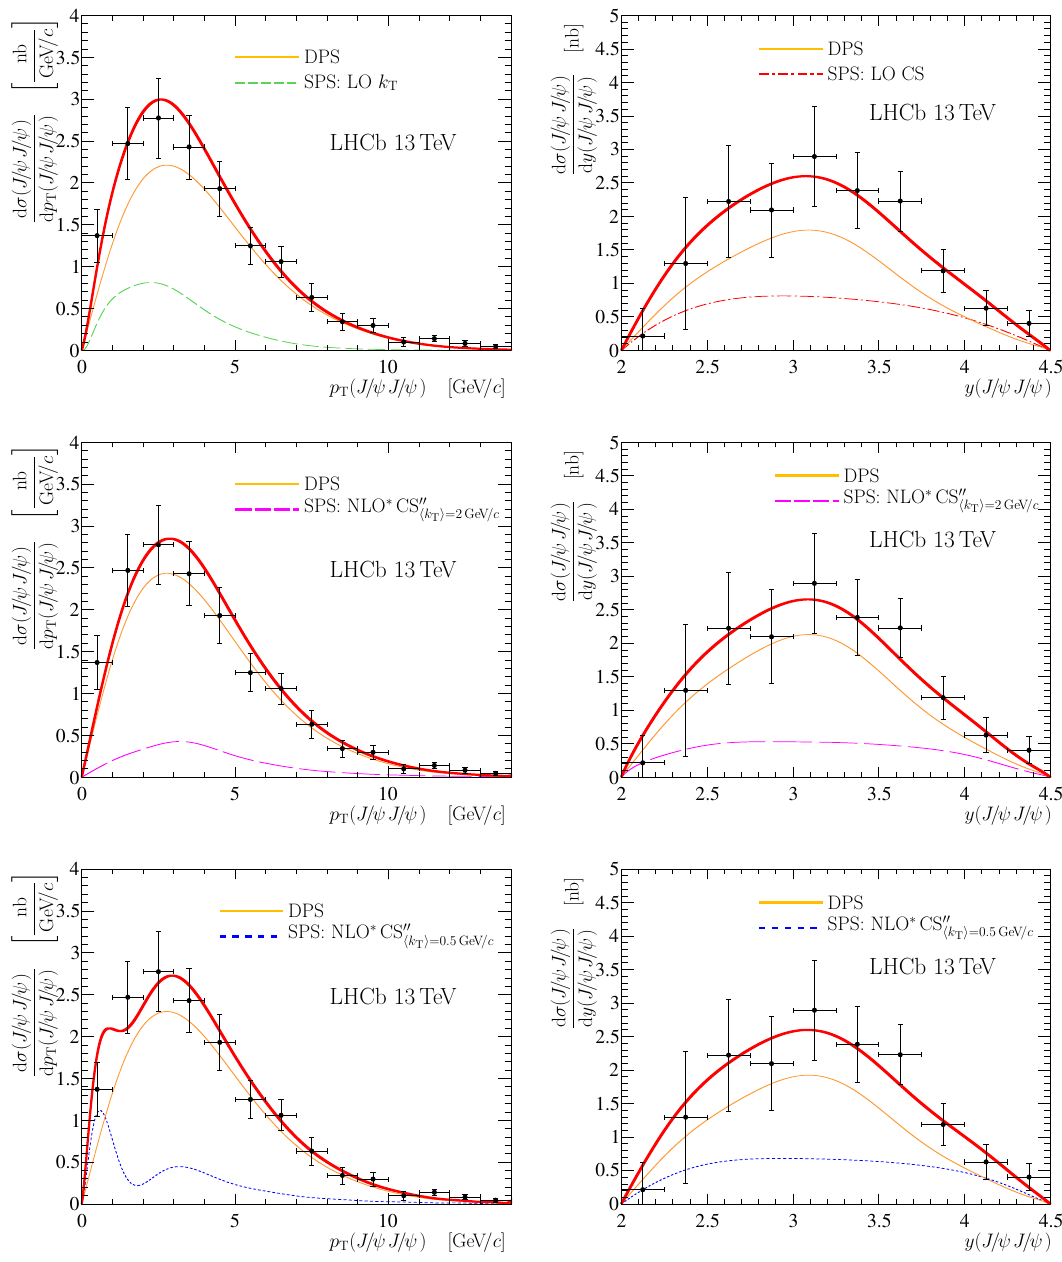
Figure 9 . Result of templated DPS (cid:12)t for d (cid:27) ( J= J= ) error bars represent the data. The total (cid:12)t result is shown with the thick (red) solid line and the DPS component is shown with the thin (orange) solid line.